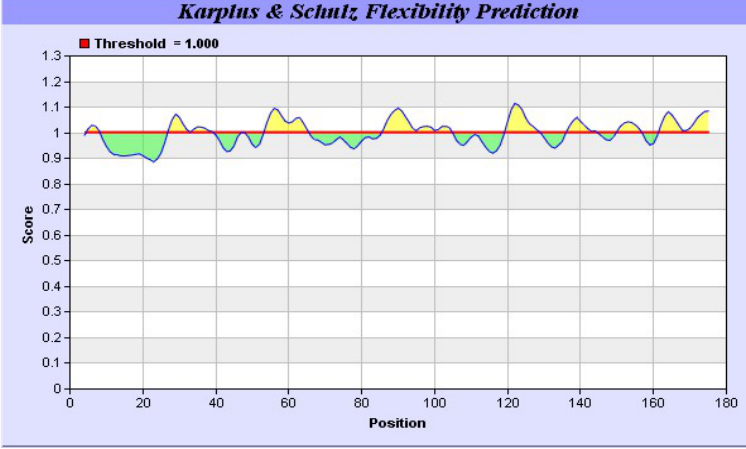
Figure 11. Predicted flexibility regions of yak IGF2. The flexibility residues forming a flexibility loop were directed above the threshold value and represented by the residues RPSSRINRRSRG